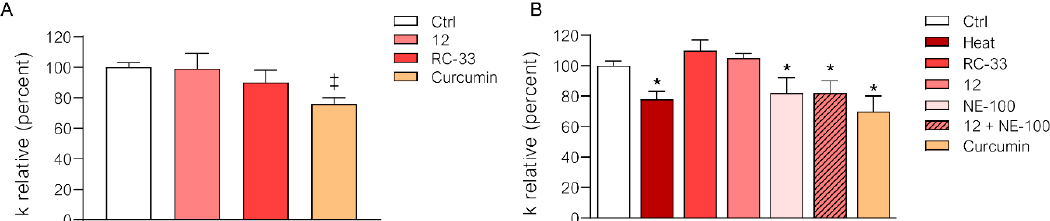
Figure 9. Effect of the compounds 12 , RC-33 and curcumin on the water permeability of HeLa cells in non-stressed condition ( A ) and in heat-stress condition ( B ). ( A ) Hela cells were incubated at 21 °C for 3 h with the compounds at the final concentration of 20 μ M. Vehicle cells are incubated without compounds (white bars). Bars represent the osmotic water permeability of HeLa cells expressed as percent of k relative. ( B ) HeLa cells were exposed to a 150 mOsm osmotic gradient in three different conditions: 1) Untreated cells (Controls, Ctr); 2) cells treated at 42 °C for 3 h (heat-stressed, Heat); 3) heat-stressed cells pre-treated with the compound 12 , RC-33, NE-100, NE-100 + 12 combination, and curcumin at 20 μ M final concentration. Values are means ± SEM of 4–15 single shots (time course curves) for each of 4–18 different experiments. * p < 0.05 vs. Ctr, 12 , RC-33; ‡ p < 0.05 vs. vehicle, 12 , RC-33 (ANOVA, followed by Newman–Keuls’s Q test).